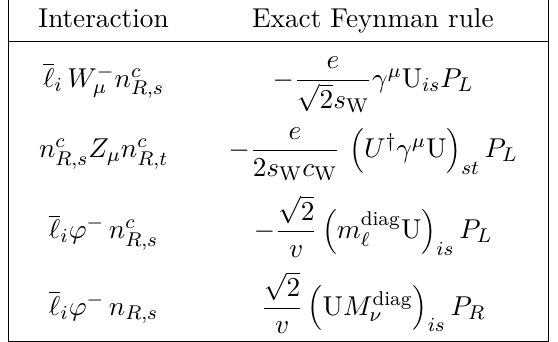
Table 12. Feynman rules for Majorana neutrinos in the mass eigenbasis, without applying the seesaw approximation. The lepton flavour index i runs from 1 to 3, the neutrino indices s and t run from 1 to 3 + n . m diag is the diagonal mass matrix of the charged ‘